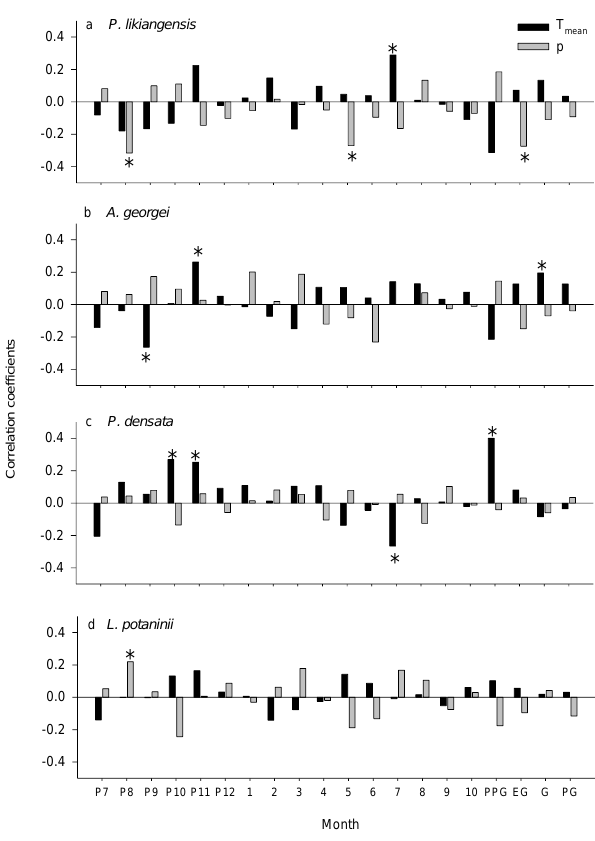
Figure 4. Correlation analyses of response function between the residual chronologies and the monthly climatic factors. * Significant at p < 0.05. PPG stands for previous post-growing season; EG stands for early growing season; G stands for growing season; PG stands for post-growing season. The first two ordination axes in RDA explained 32.8 % of the network’s total variance (Figure 5). Axis I accounted for 21.7% and had negative loadings for all species, axis II accounted for 11.1%, and had positive loadings for residual chronologies of A. georgei , P. likiangensis , and L. potaninii , and negative loadings for residual chronologies of P. densata . The previous July temperature was positively associated with the first axis, whereas T mean of the previous November and precipitation of the previous August showed a negative association. The second axis was positively associated with T mean of the current July and negatively with T mean of the previous post-growing season (September – October). The current May precipitation was associated with both axes: positive with axis I and negative with axis II. RDA showed similar results as compared to RAF, presenting positive effects of the current July temperature on the growth of P. likiangensis and negative effects on P. densata , of the previous post-growing season temperature on P. densata (positive) and P. likiangensis (negative), of the previous November temperature on four species (positive), of the previous August precipitation on L. potaninii (positive) and P. likiangensis (negative), and of the current May precipitation on P. likiangensis (negative). RDA also showed significant correlations between tree growth and climatic factors that the response function did not detect. For instance, the current May precipitation and current July T mean had negative and positive impacts on growth of A. georgei , respectively. Previous July temperature negatively affected radial growth of the four species (Figure